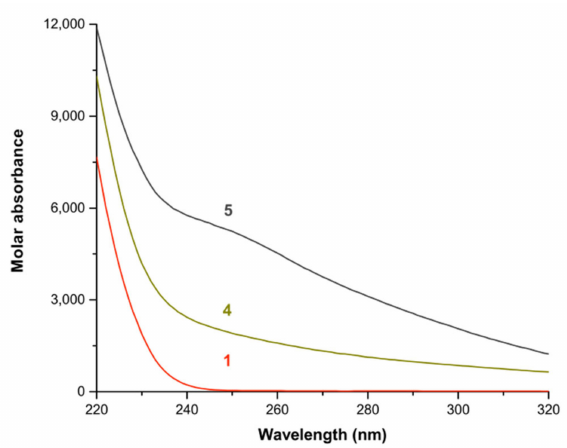
Figure 4. Calculated electronic spectrum of the manganese(II)–ethylenediamine species in methanol: (1) Mn 2+ ; (2) [Mn(en)] 2+ ; (3) [Mn(en) 2 ] 2+ .